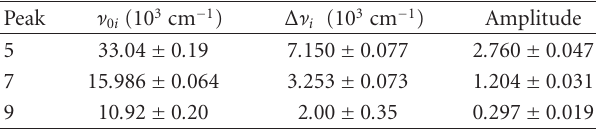
Table 3: Best-fitted parameters of the optical absorption spectra of thick sample (shown in Figure 1) of topaz heated at 200 ◦ C for Gaussian line shapes. The Gaussian amplitudes are given in absorbance